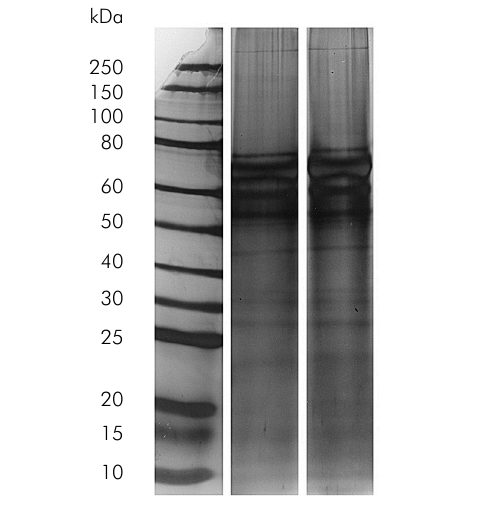
Figure 4. SDS-PAGE of HDE antigen stained with silver